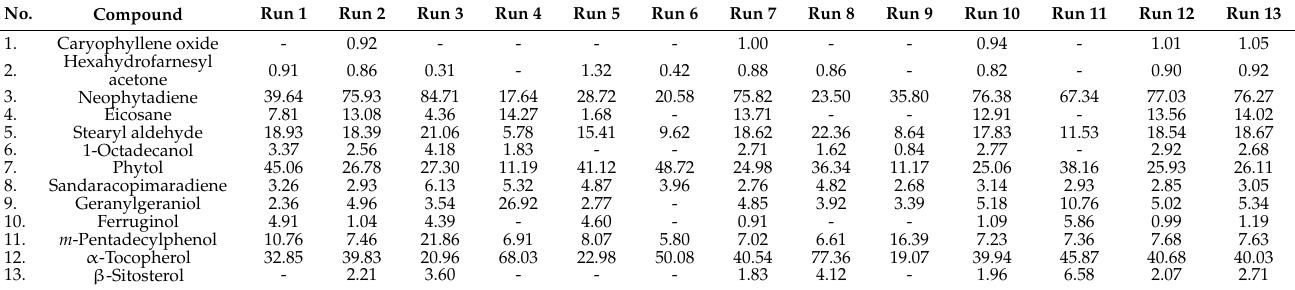
The response surface regression coefficients of the polynomial function for the α - tocopherol relative amount of T. distichum needles obtained by SC CO 2 is depicted in Table 4. The response surface plot showing the influence of independent variables in coded values on α -tocopherol relative amount is depicted in Figure